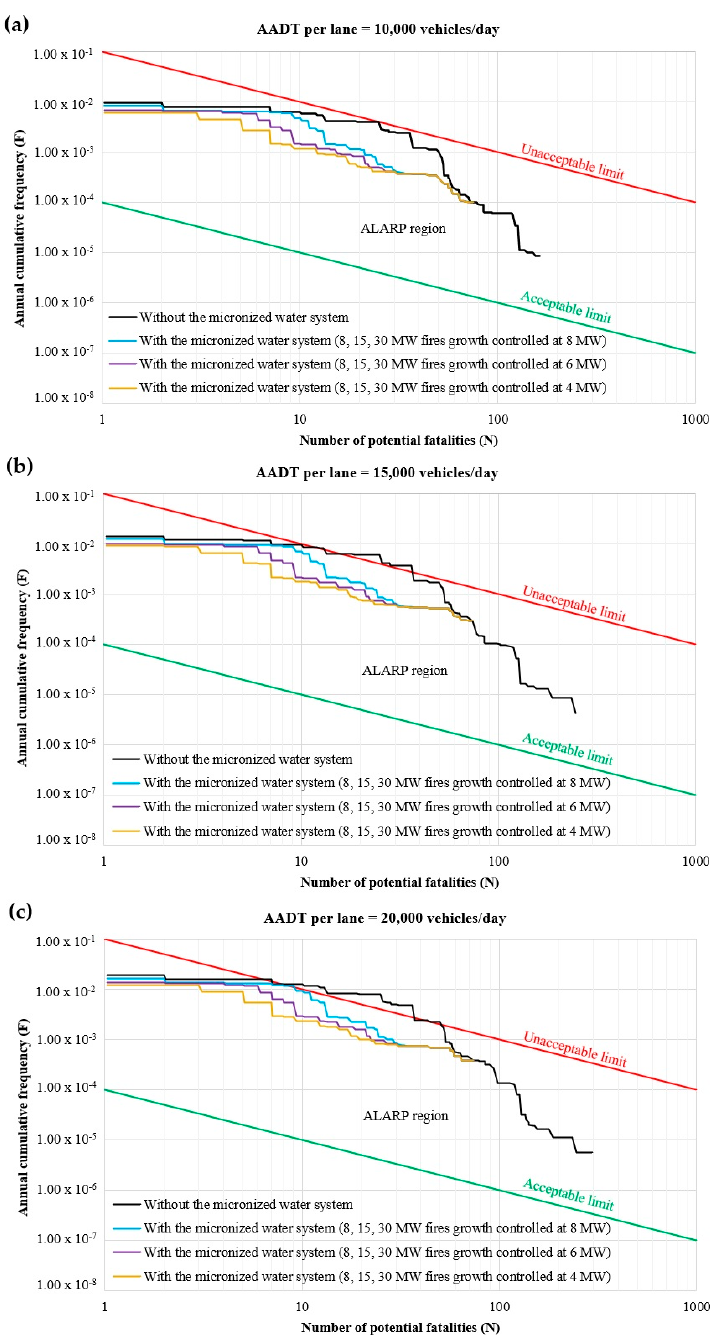
Figure 16. F-N curves with and without the use of an emergency vehicle equipped with a micronized water system for contrasting the fire growth phase of certain fires (i.e., characterized by HRR max = 8, 15, and 30 MW) for AADT per lane equal to: ( a ) 10,000 vehicles/day, ( b ) 15,000 vehicles/day, ( c ) 20,000